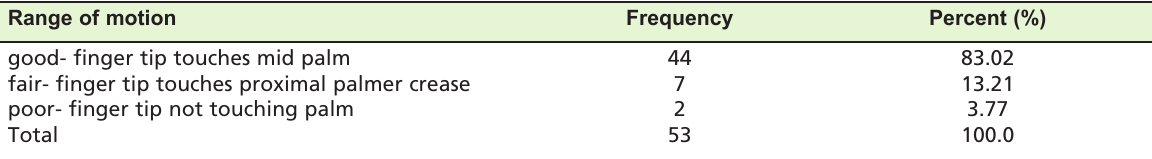
Table I: Demonstrating frequency of range of motion